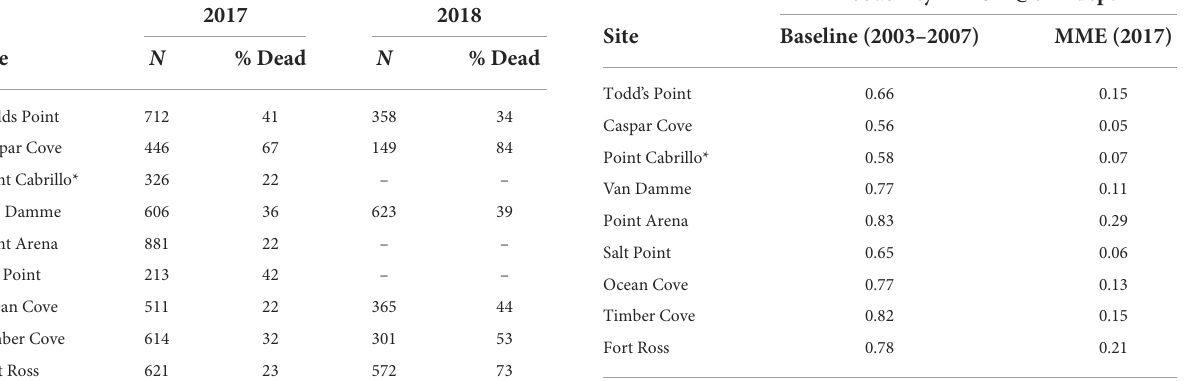
TABLE 1 Summary of red abalone mortality observations on subtidal surveys in 2017 and 2018.